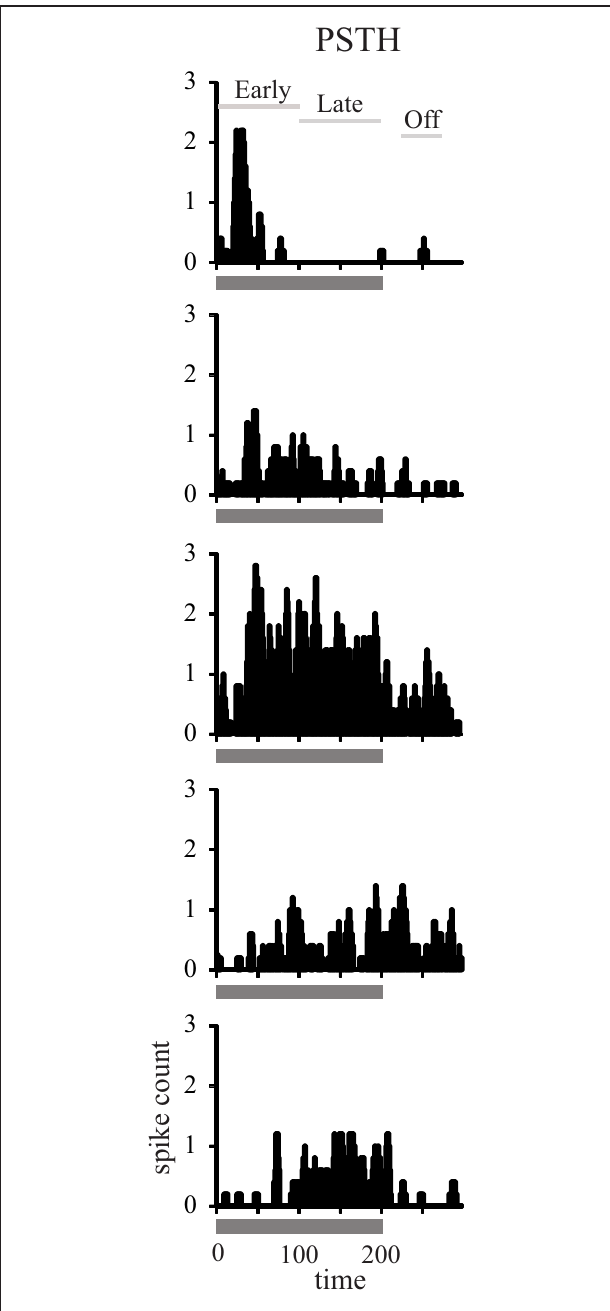
FIGURE 1 | Temporal response profiles of neuronal responses. Recorded neuronal responses varied along a continuum from early phasic (top), tonic (middle), to the late period only (bottom).